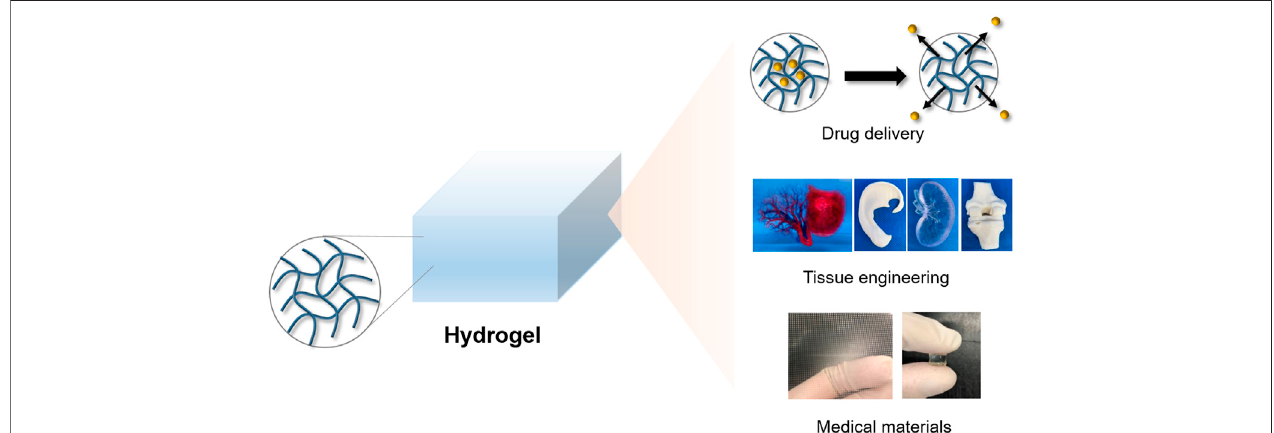
FIGURE 1 | Applications of hydrogels in different areas.